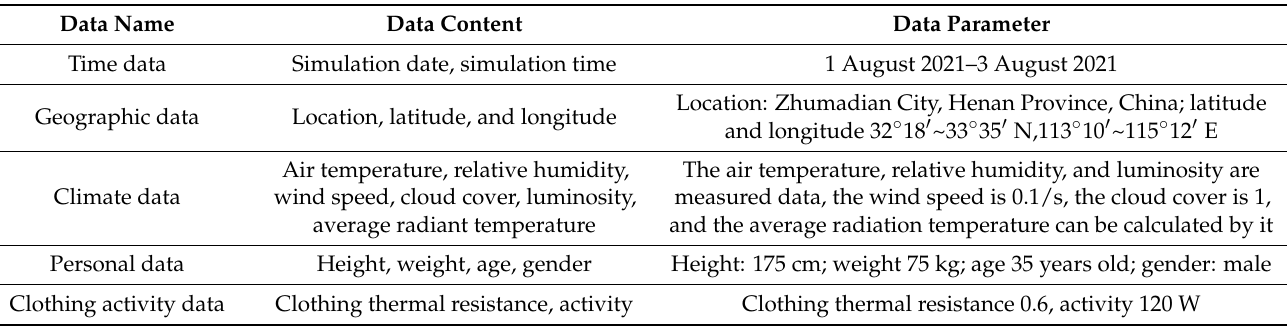
Table 2. RayMan model input